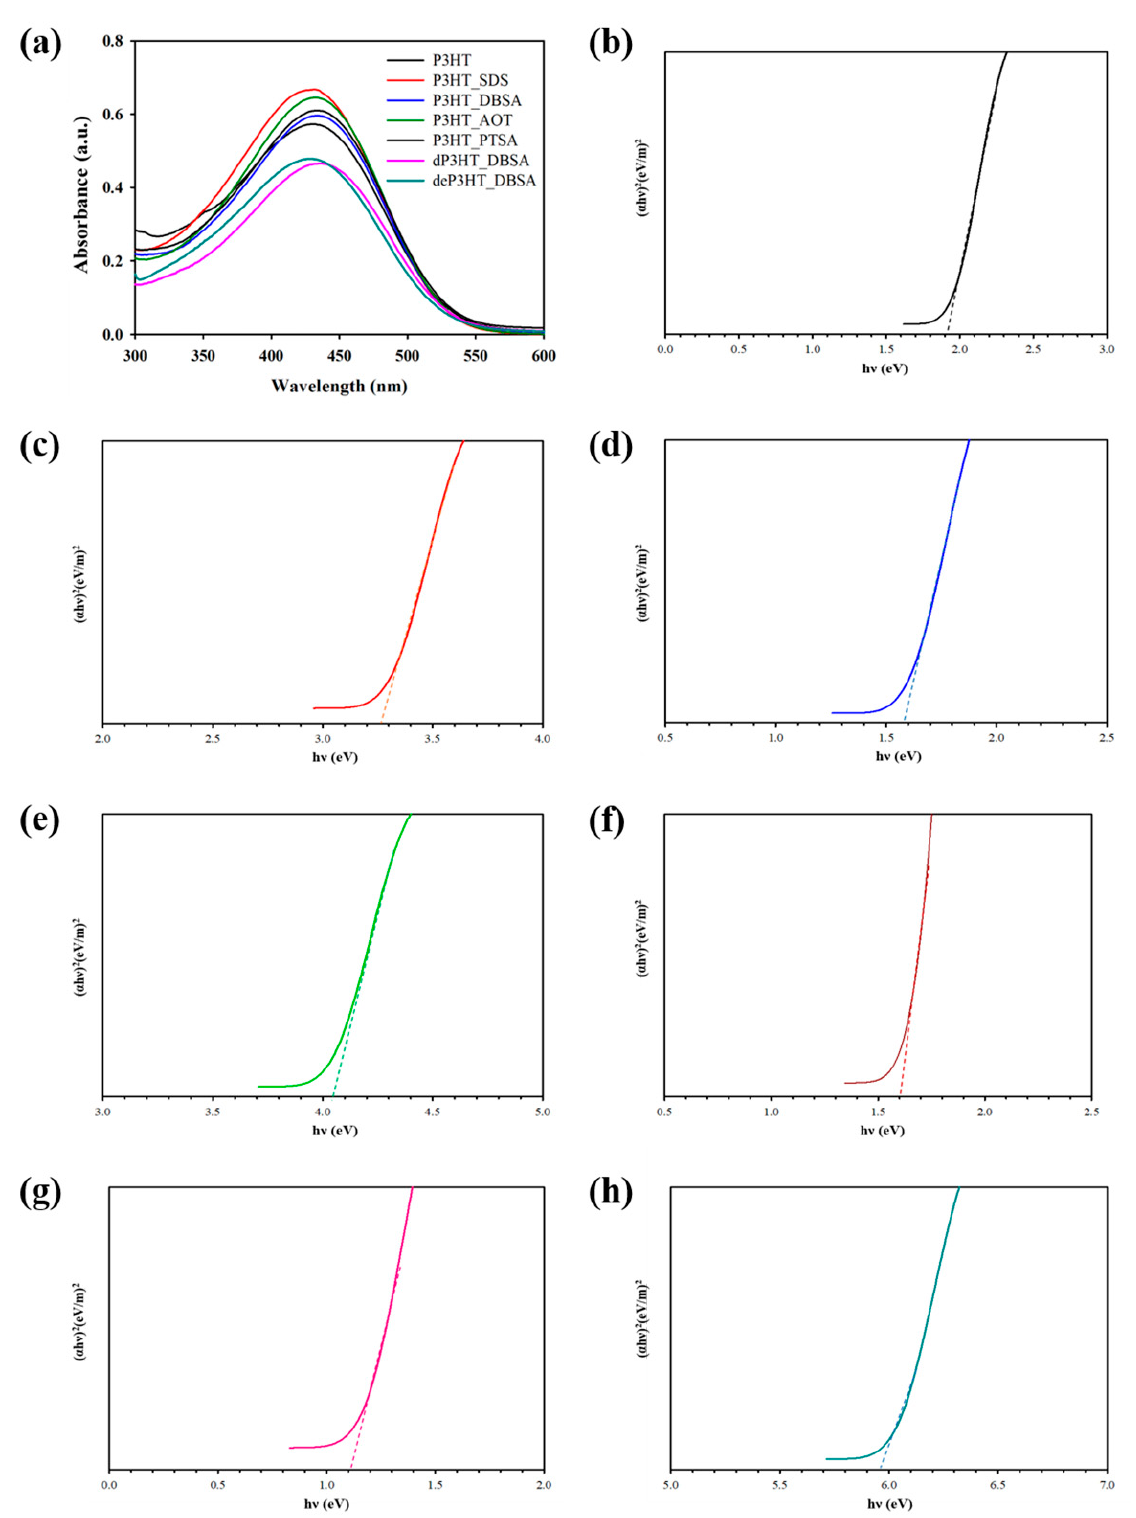
Figure 2. UV-vis absorption spectra and Tauc plots of P3HT: ( a ) UV–vis absorption spectra of P3HT synthesized under different conditions; ( b ) Tauc plot of P3HT; ( c ) Tauc plot of P3HT_SDS; ( d ) Tauc plot of P3HT_DBSA; ( e ) Tauc plot of P3HT_AOT; ( f ) Tauc plot of P3HT_PTSA; ( g ) Tauc plot of dP3HT_DBSA; and ( h ) Tauc plot of deP3HT_DBSA.